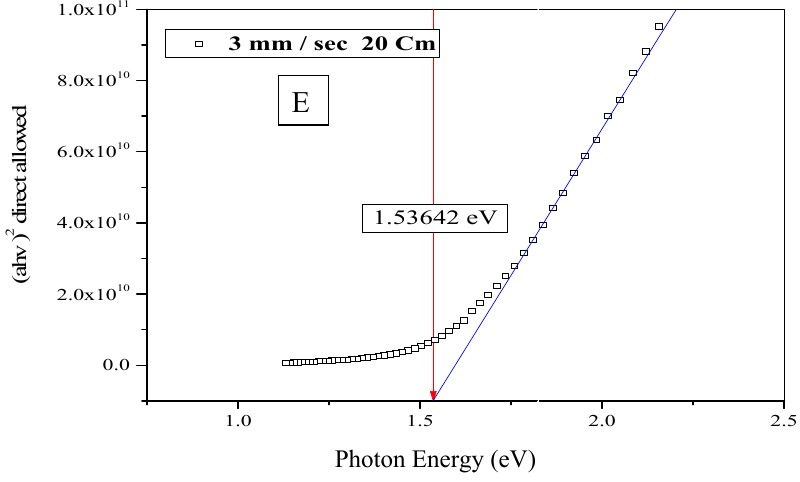
Fig. 4E: Energy band gap of CuO at different preparations